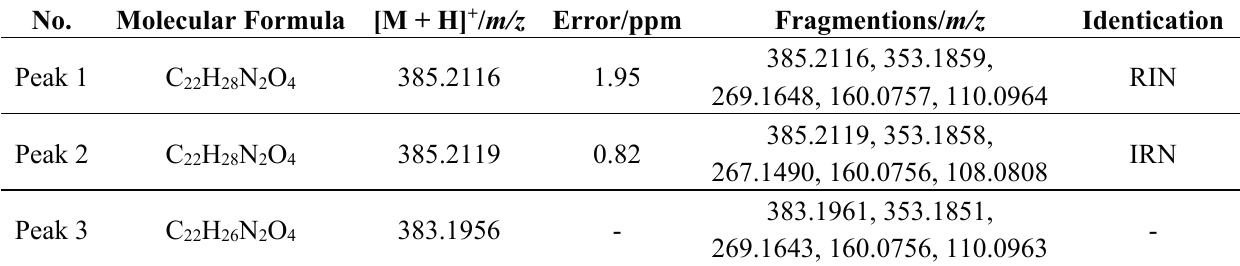
Table 2. The fragment ions of characteristic peaks by UPLC-Q-TOF analysis.